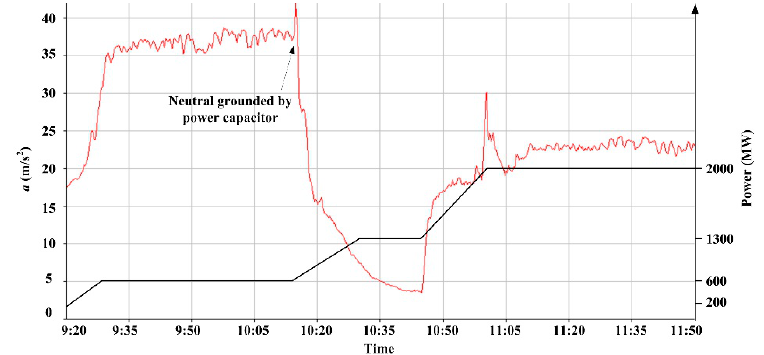
Figure 2. Time variation of transformer vibration and transmitting power of the UHVDC system.